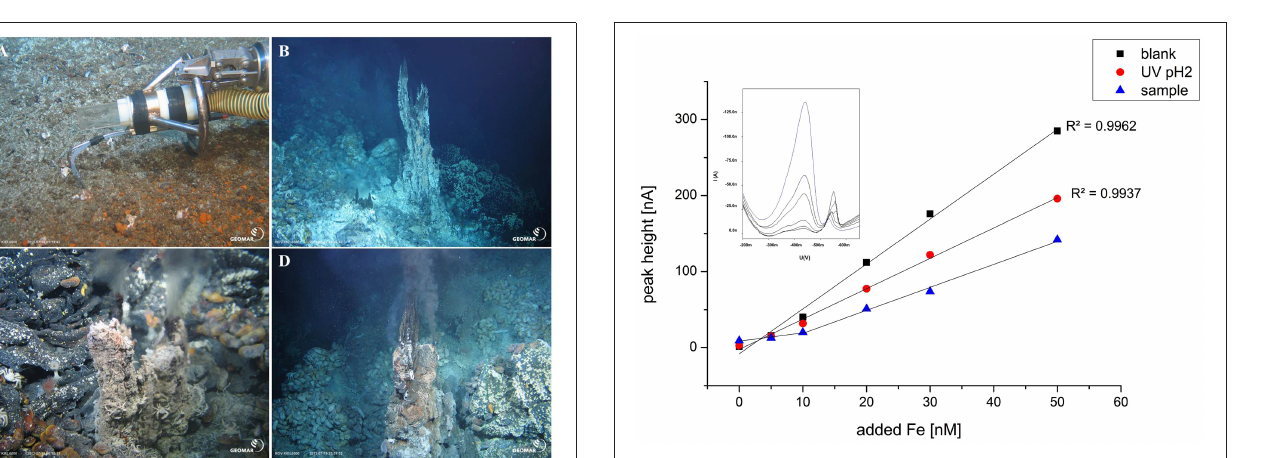
FIGURE 3 | Typical titration curve exemplarily chosen for sample 27 ROV 11 with Fe standard additions at pH 8.15 and 100 µ M SA for the reagent blank, a UV digested sample at pH 2 and the regular sample. The sample without any Fe addition was equilibrated overnight. The voltammogram shows the standard additions of Fe to sample 27 ROV